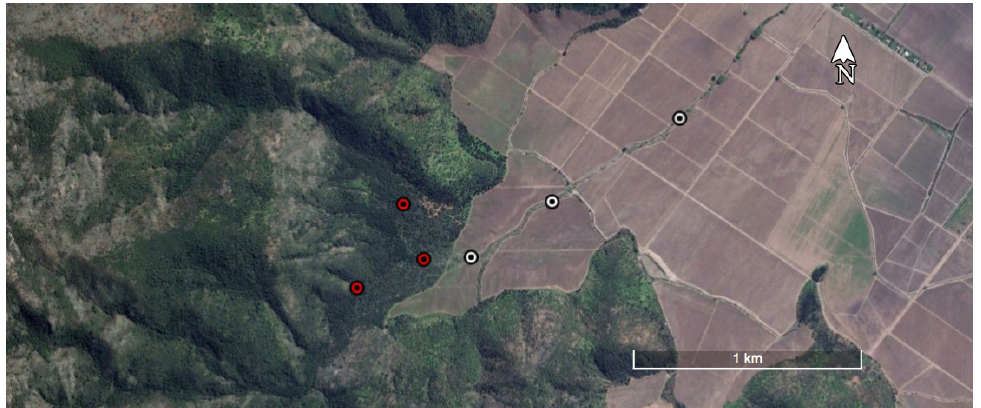
Figure 2. Image of vineyard in central Chile showing a typical farm landscape, including natural areas, cropland areas and vegetation strip corridors within crops. As shown in this landscape, we sampled six sites in this study: three sites within “corridors” (white circles) and three sites in adjacent natural vegetation (red circles), 200–500 m away from the cultivated areas.